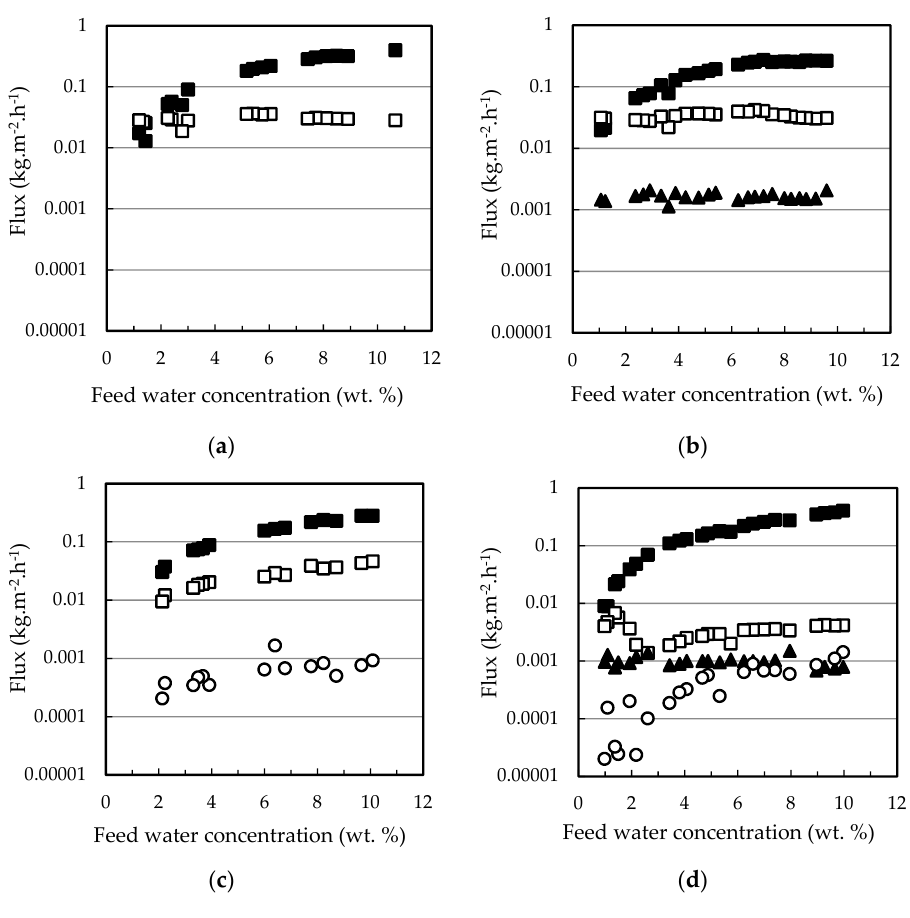
Figure 5. Individual component fluxes as a function of feed water content for mixtures of different composition: ( a ) Water + ethanol, ( b ) water + ethanol + ethyl lactate, ( c ) water + ethanol + lactic acid, ( d ) water + ethanol + ethyl lactate + lactic acid. ( ) Water, ( ) ethanol, ( ) ethyl lactate, ( ) lactic acid. PERVAP TM 1131 membrane at T = 60°C.